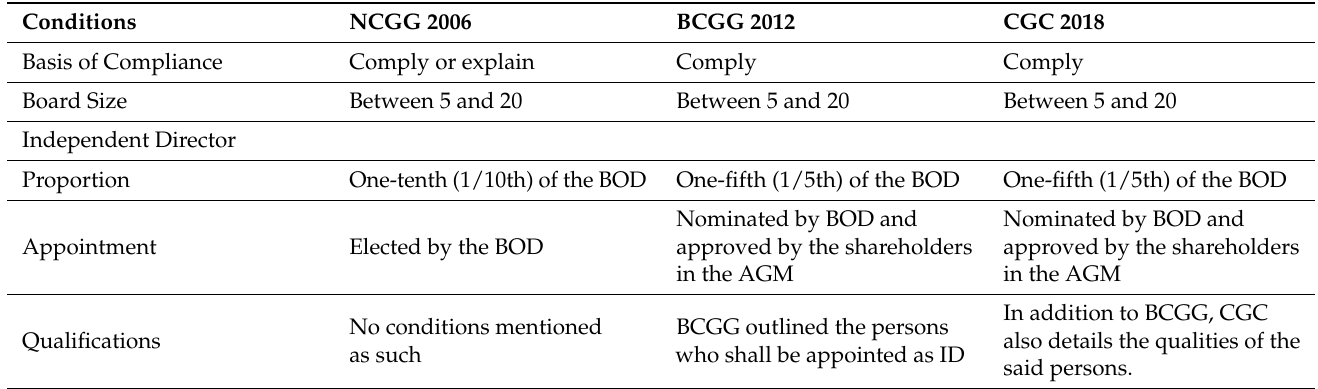
Table 1. Differences among the corporate governance guidelines issued by